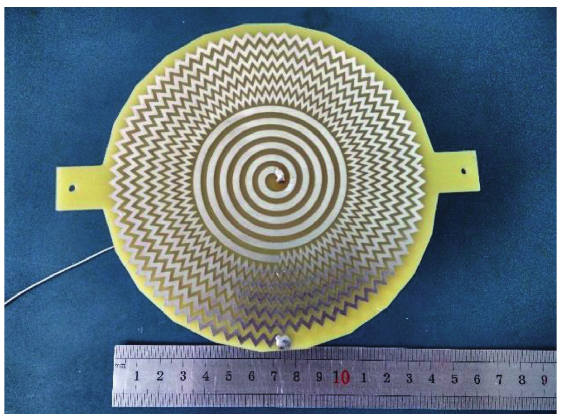
Figure 19: Prototype of the SAAS